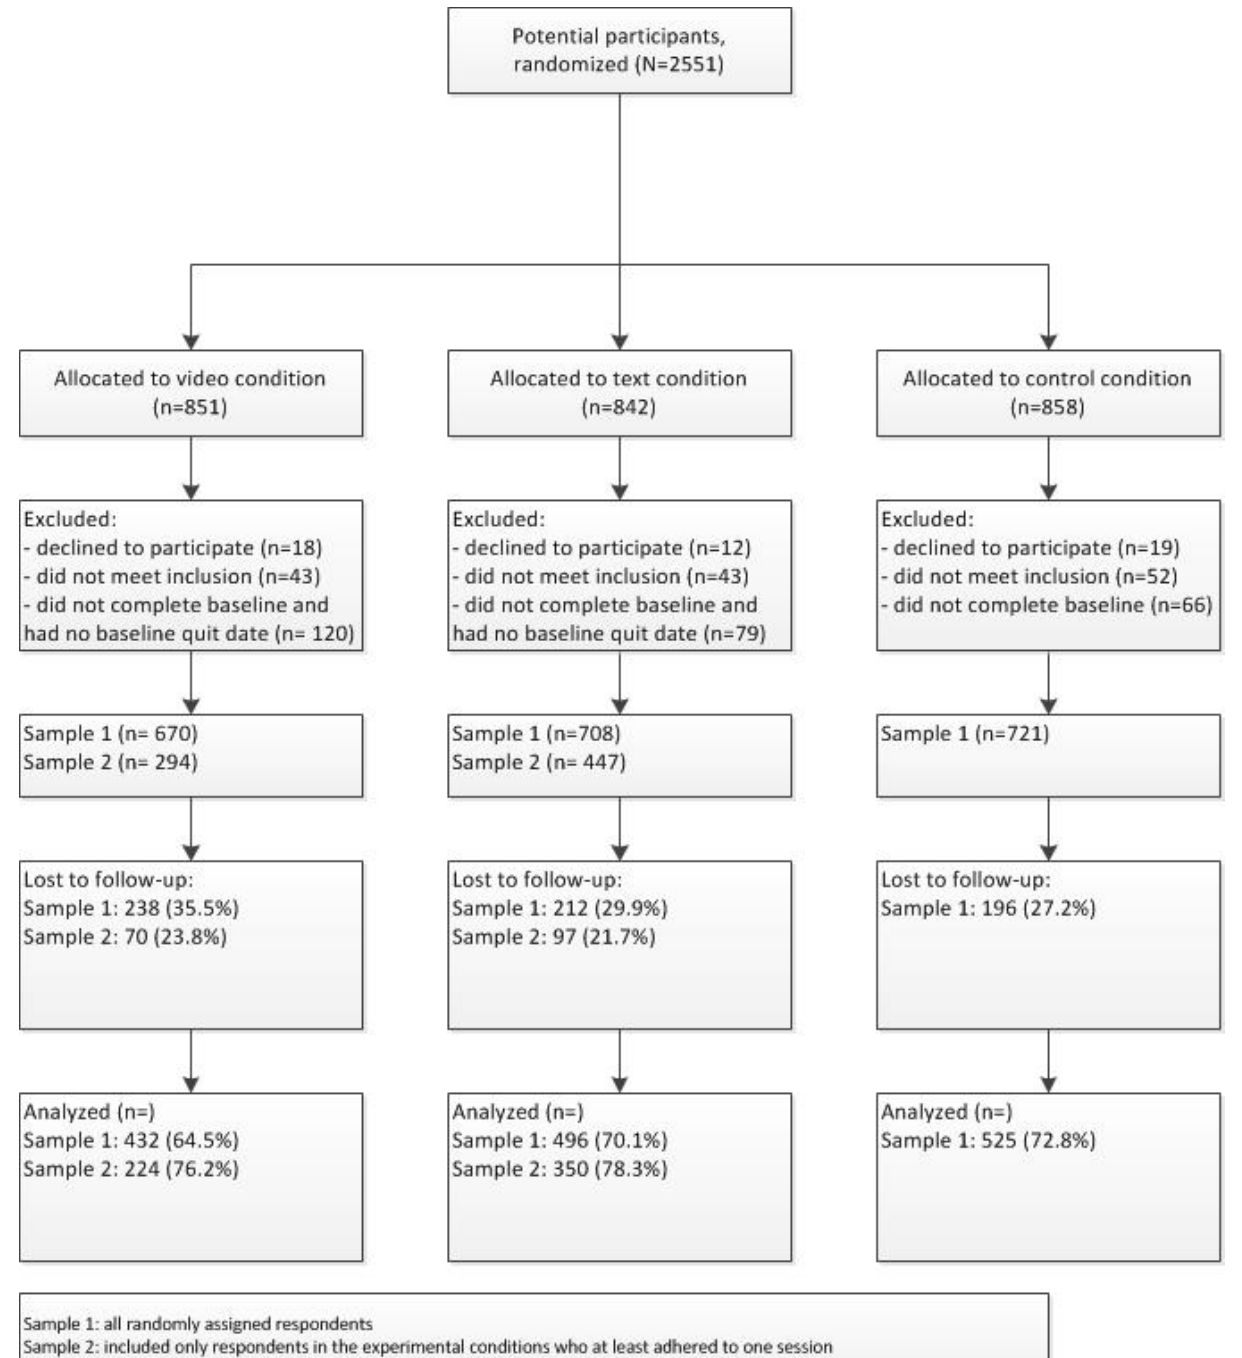
Figure 2. Flowchart of participant enrollment and inclusion. Sample 1: all randomly assigned respondents; sample 2: only respondents in the experimental conditions who adhered to at least one